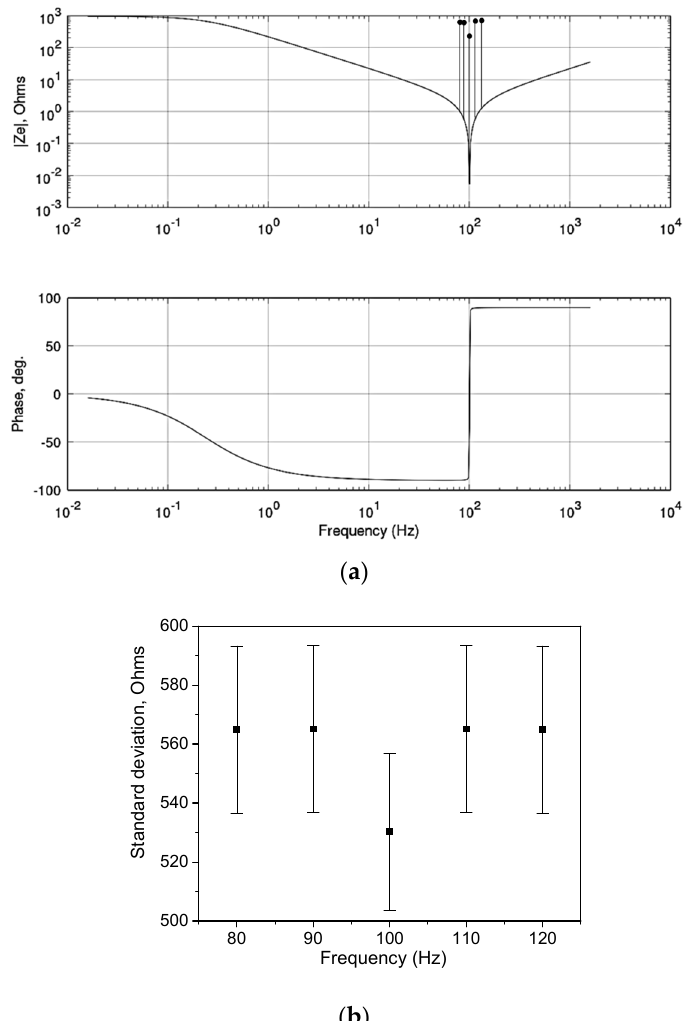
Figure 8. ( a ) Modelled characteristics of the module and the phase of the complex resistance for the equivalent circuit from Figure 2 for the case of KNbO 3 thicker film based piezoelectric transducer; ( b ) standard deviation between experimental and modelled curves.